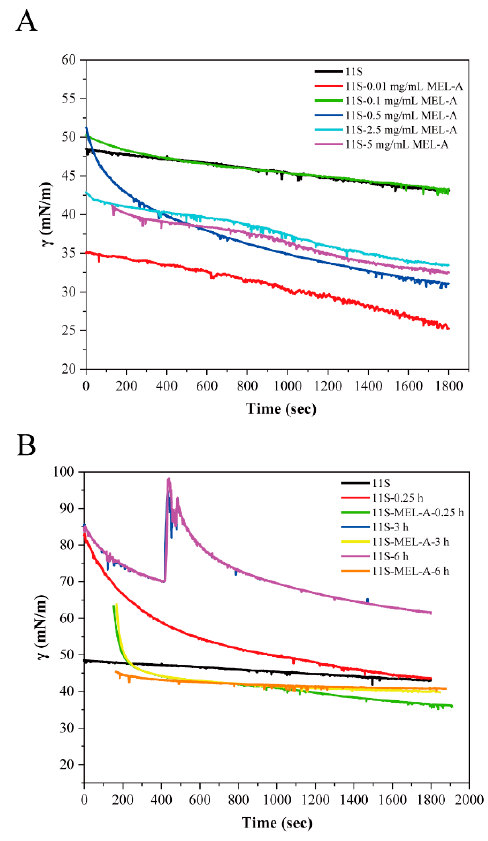
Figure 1. ( A ) The surface tension changes of heat-treated 11S and 11S-MEL-A mixtures adsorption at the air–water face with time. ( B ) Surface tension versus the concentrations of MEL-A during ad- sorption.